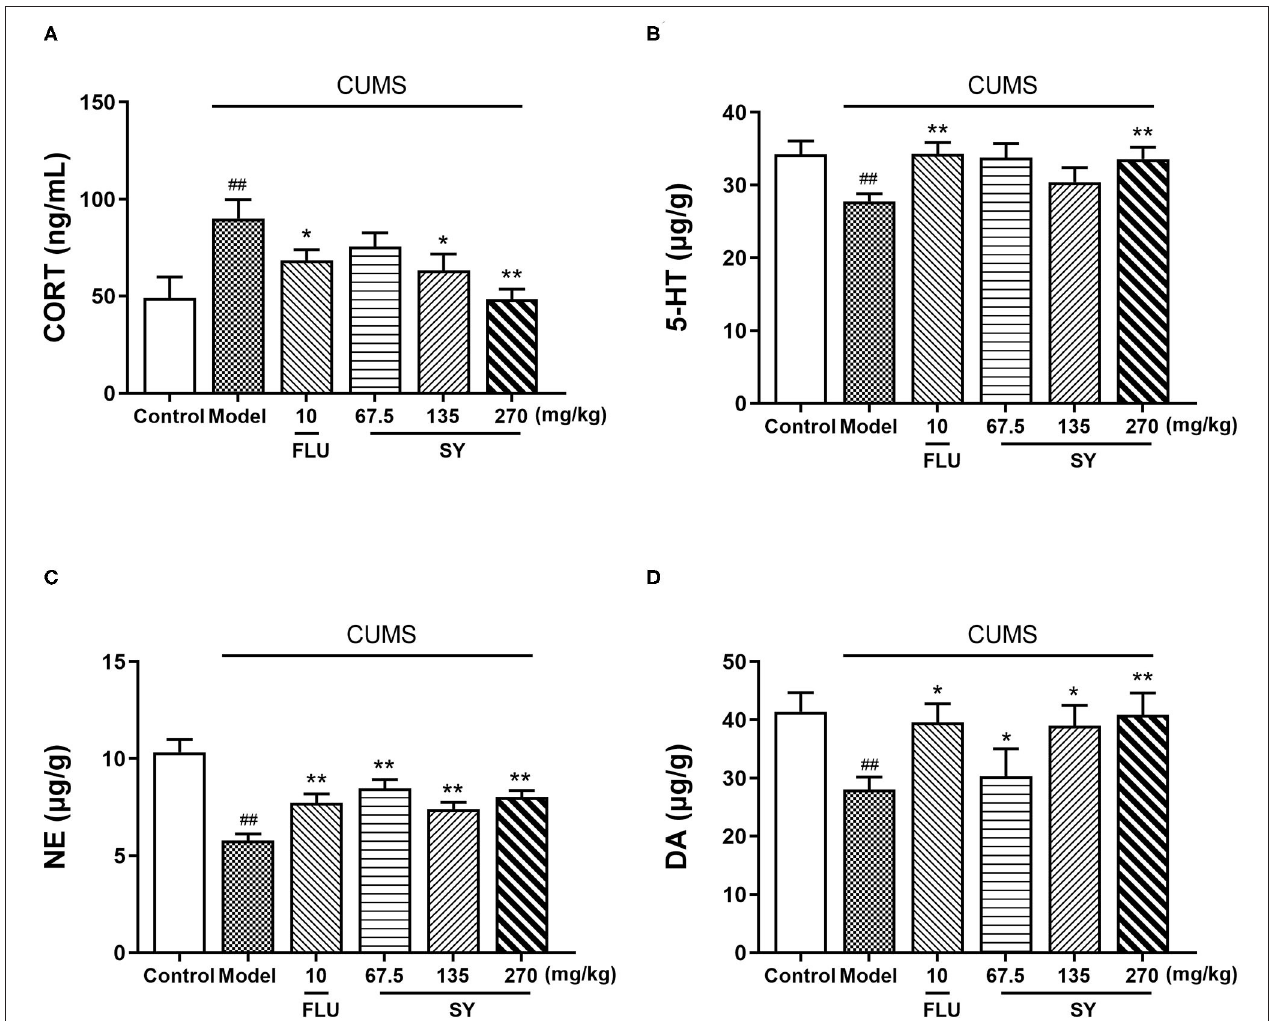
FIGURE 4 | Effects of SY on the levels of CORT, 5-HT, NE, and DA in CUMS rats. (A) Levels of corticosterone (CORT). (B) Levels of 5-hydroxy tryptamine (5-HT). (C) Levels of norepinephrine (NE). (D) Levels of dopamine (DA) in each group. Data represent the mean ± S.E.M. ( n = 10 per group). ## p < 0.01, vs. the control group; * p < 0.05, ** p < 0.01 vs. the CUMS